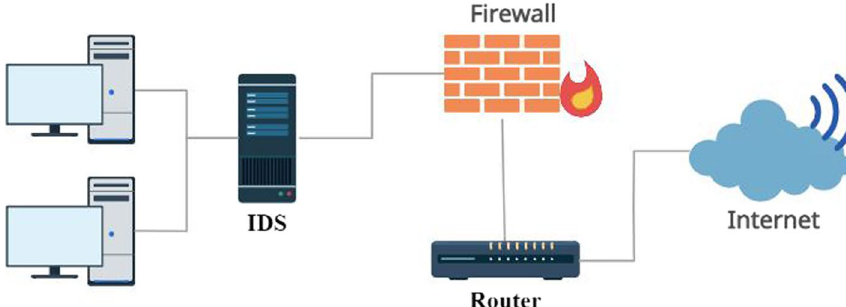
Fig. 3 Structure of intrusion detection